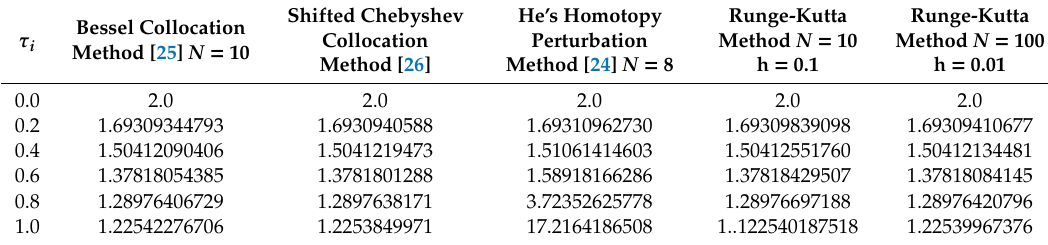
Table 3. The approximate solutions of the other method.